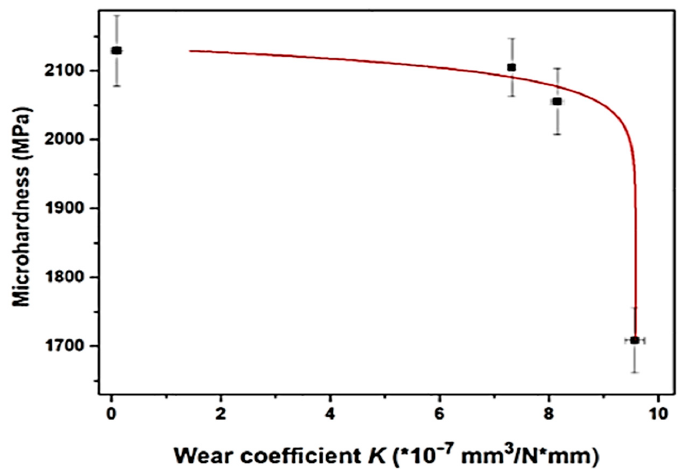
ffi cient of NiTec